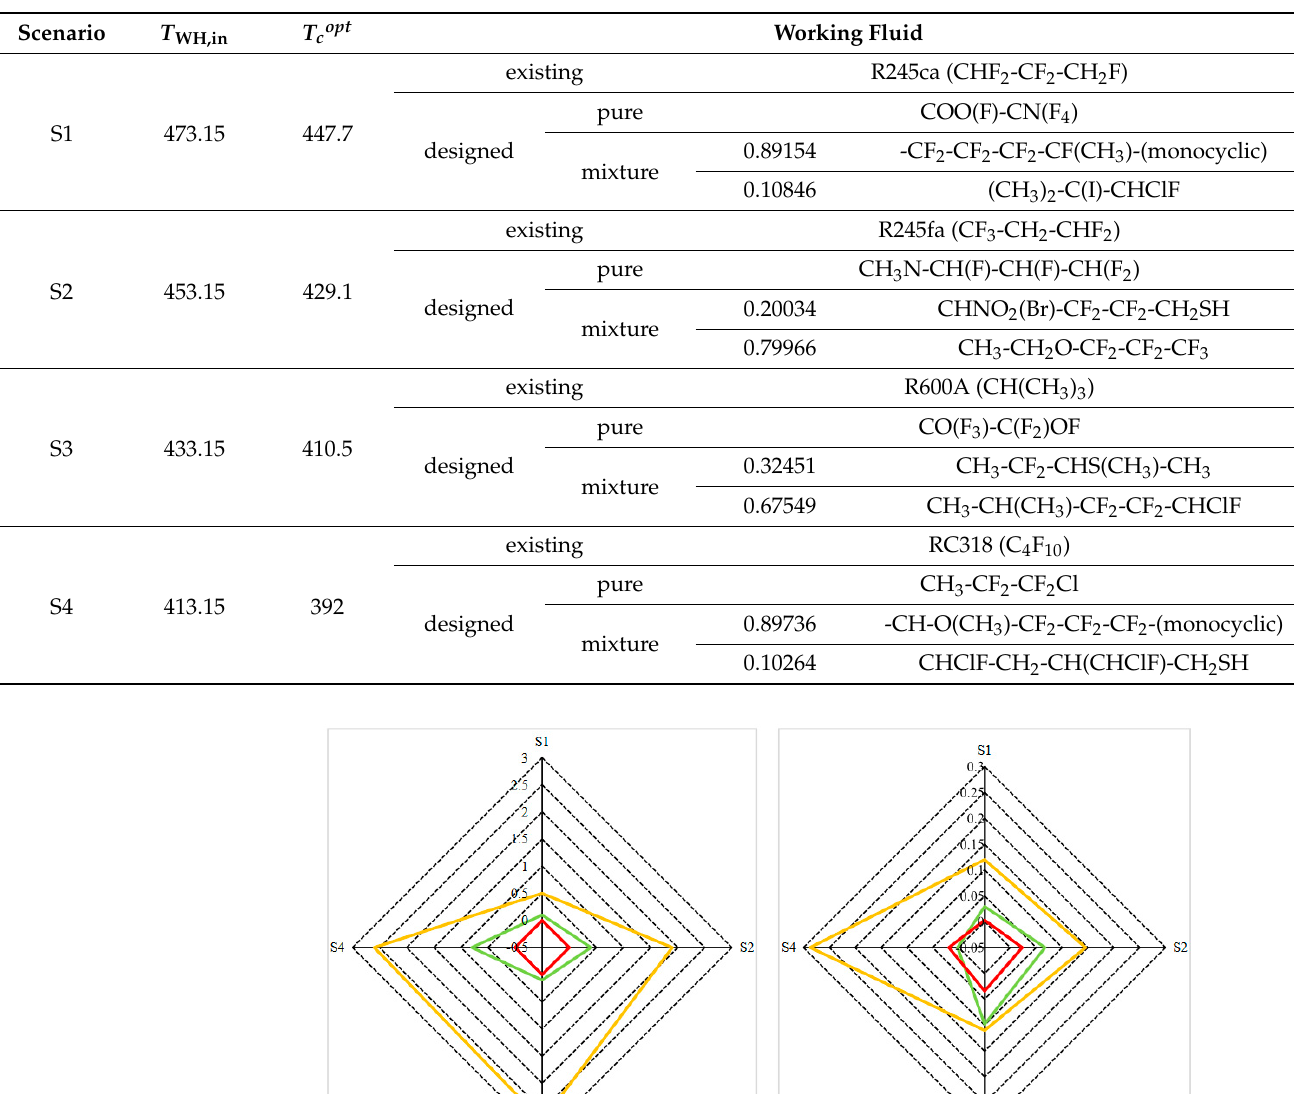
Table 3. The optimal designed and existing working fluids for the given inlet temperatures of waste heat.